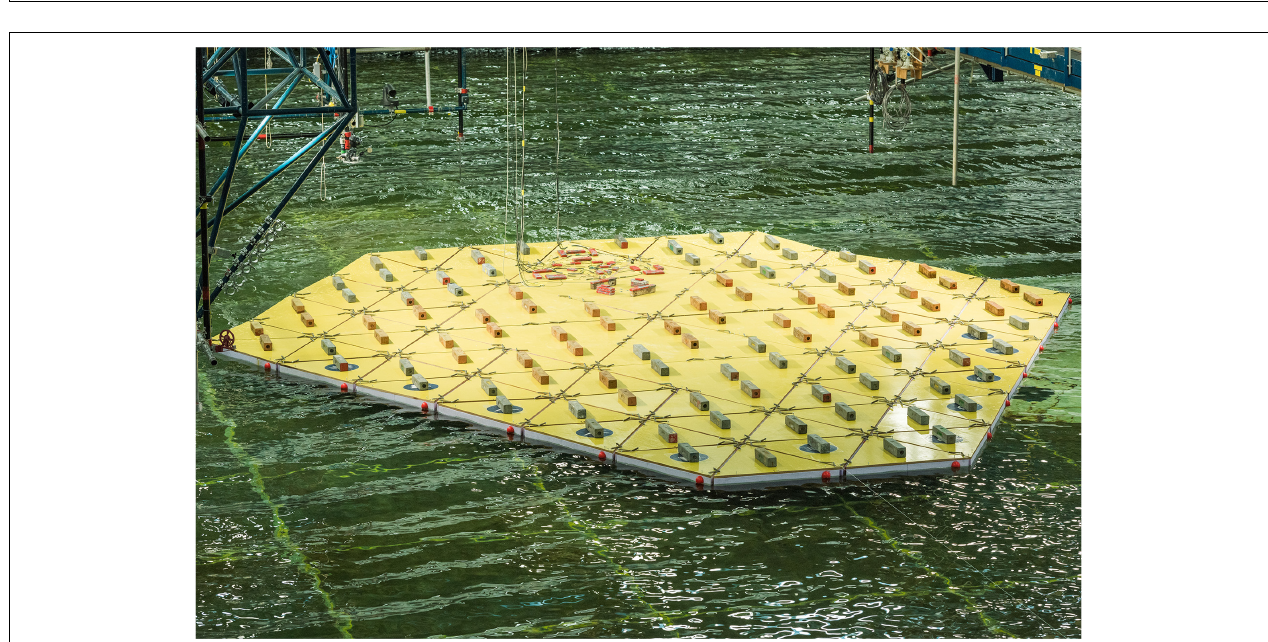
FIGURE 2 | Initial model test of the multi-use platform concept with equilateral